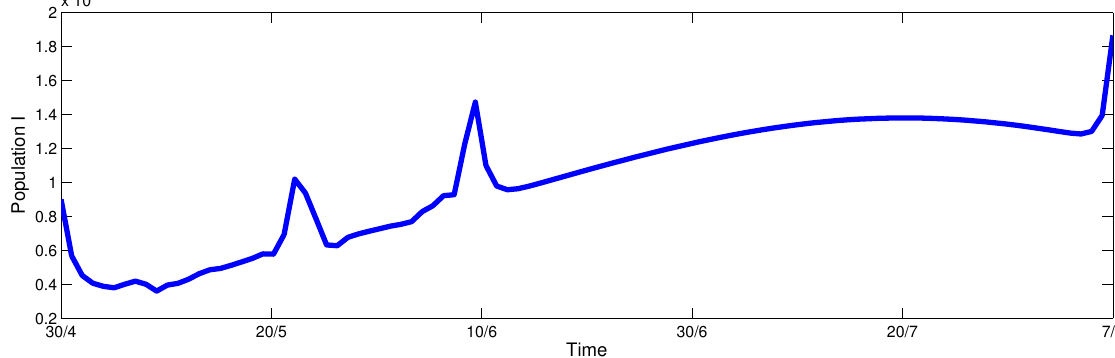
Fig. 7. The graph of u with respect to time t based on Table 1, 2 and G 1 = 0 . 005 and G 2 = 1000 starting from 30 / 4 / 2020 to 7 / 8 / 2020 .